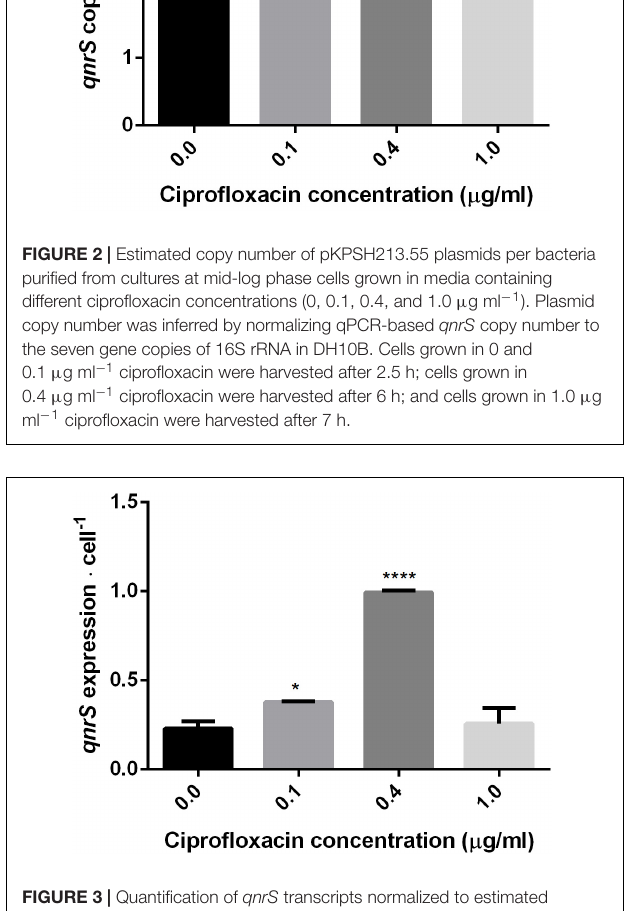
phase. However, when ciprofloxacin exceeded 1.0 µ g ml − 1 ,